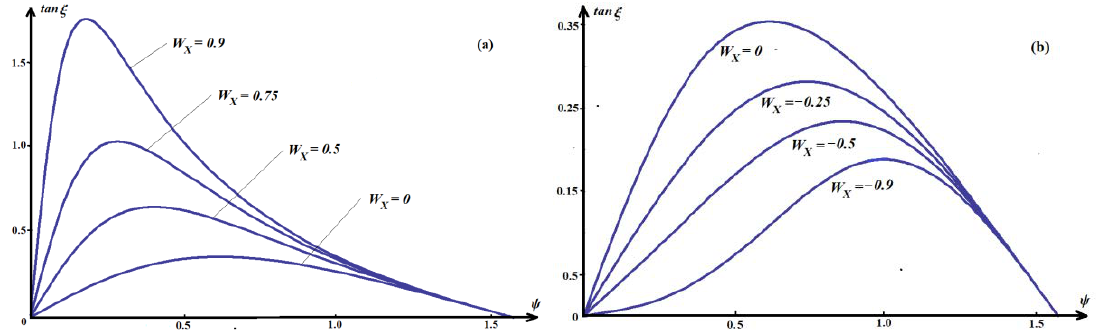
k k   depending on the ray angle tan  for Figure 3. Directions of ship waves  : / tan( ) Figure 3. Directions of ship waves ψ : − k Y / k X = tan ( ψ ) depending on the ray angle tan ξ for different values of shear Y X current: ( a ) Unidirectional with the ship ( W X > 0) shear current; ( b ) Oncoming ( W X < 0) shear different values of shear current: ( a ) Unidirectional with the ship ( 0 X W  ) shear current; ( b ) On- coming ( 0 X W  ) shear current.